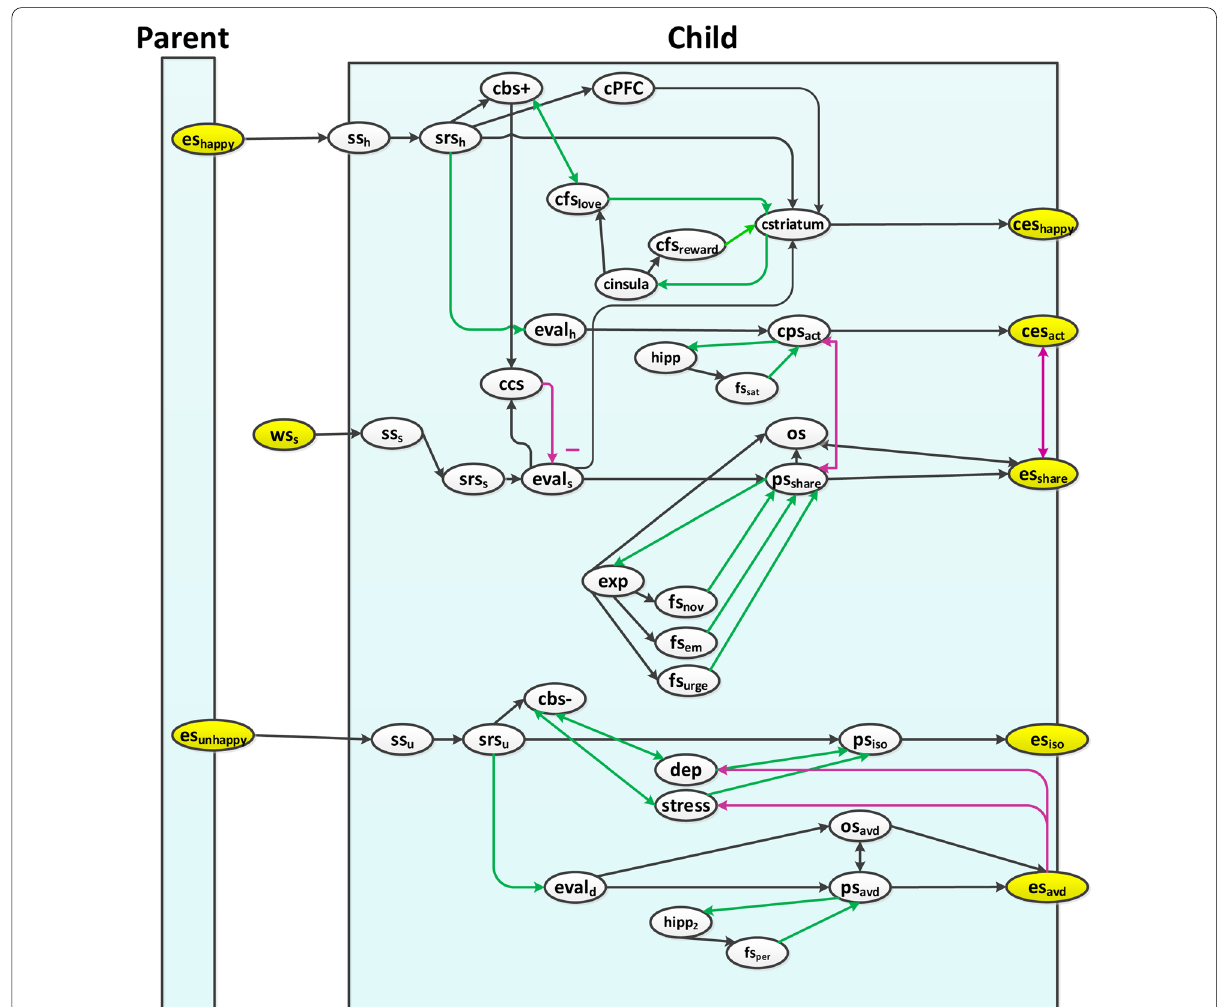
Fig. 1 Connectivity of the base level (Level I) of the network model of a child influenced by parent